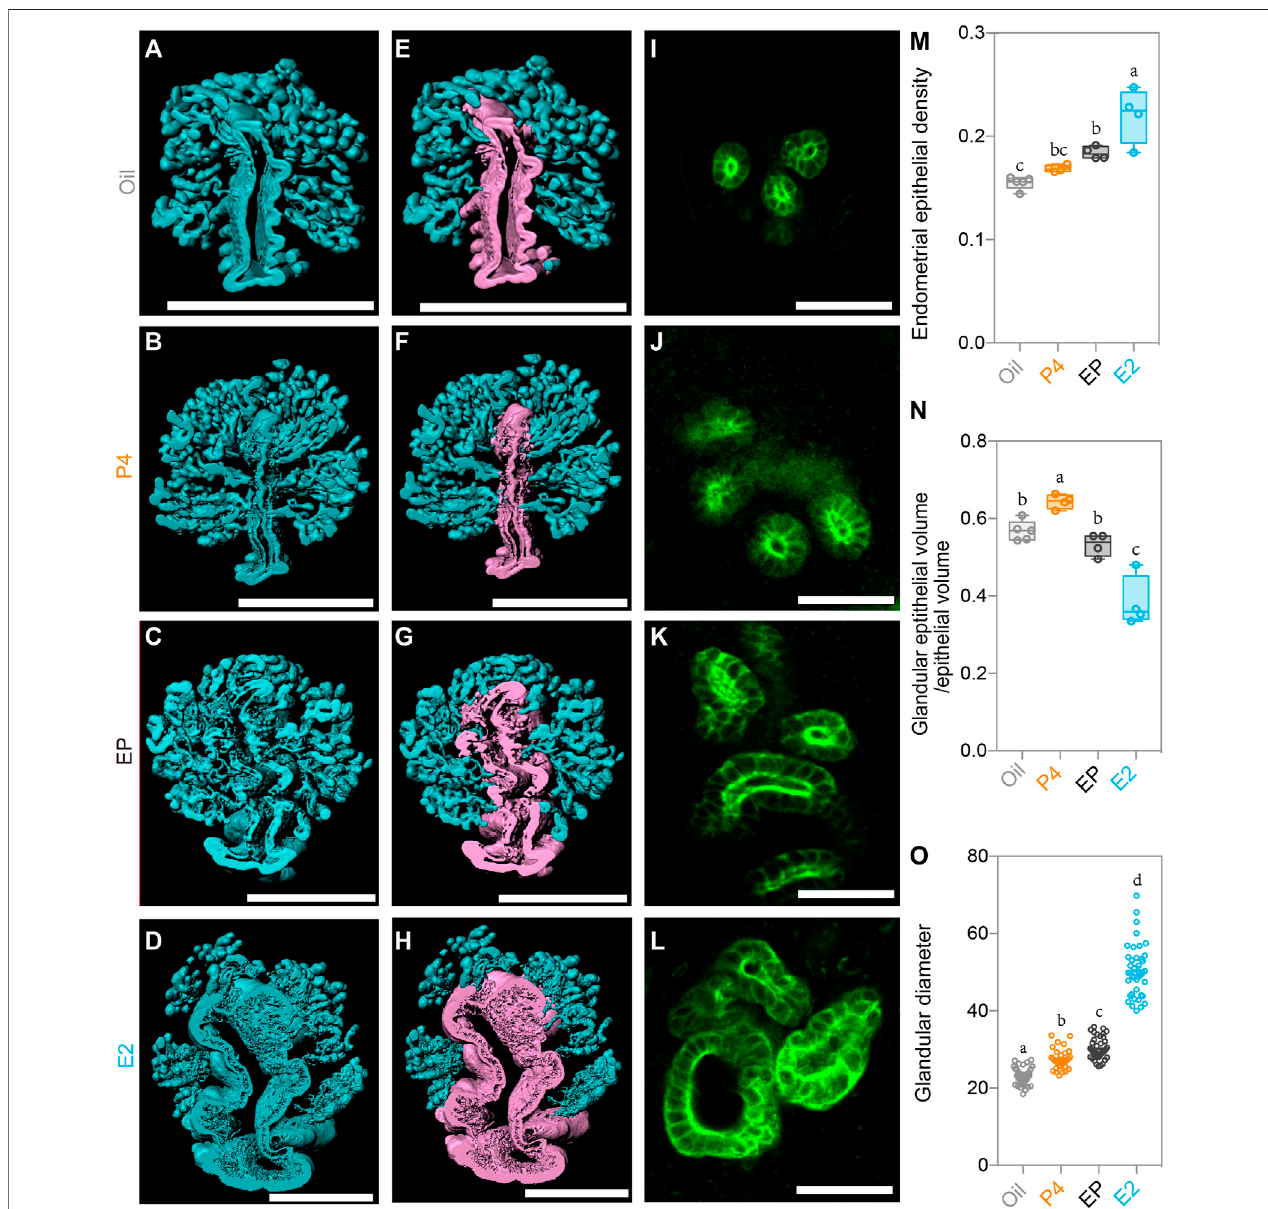
FIGURE6| Uterineepithelialalteration inthe3Dlevelaftersteroidhormonetreatment. (A – D) 3Drenderingoftheuterineepitheliumoftheoil-treatedgroup (A) ,P4- treated group (B) , E2 plus P4 (EP)-treated group (C) , and E2-treated group (D) . (E – H) 3D rendering of the glandular epithelium (blue) and luminal epithelium (purple) of theoil-treatedgroup (E) ,P4-treatedgroup (F) ,E2plusP4(EP)-treatedgroup (G) ,andE2-treatedgroup (H) . (I – L) light-sectionoftheuterineglandintheoil-treatedgroup (I) , P4-treated group (J) , EP-treated group (K) , and E2-treated group (L) . (M) Comparing the endometrial epithelial density with different steroid hormone treatments. (N) Comparing the ratio of glandular epithelium/total epithelium with different steroid hormone treatments. (O) Comparing the glandular diameter with different steroid hormone treatments. Scale bar of (A – H) = 350 μ m. Scale bar of (I – L) = 50 μ m. The results are shown as means ± SEM. Different letters represent signi fi cant differences ( p < 0.05). * p < 0.05, ** p < 0.01, *** p < 0.001, **** p < 0.0001. n ≥ 4.